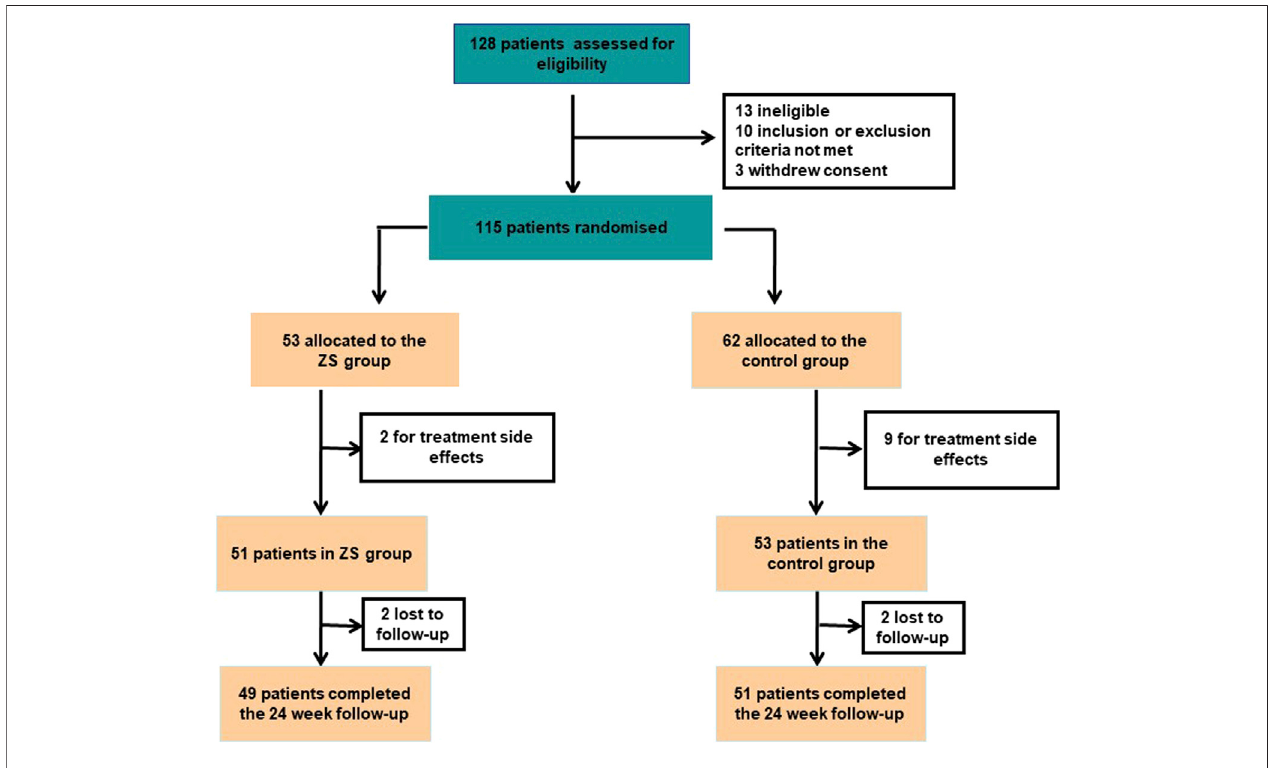
FIGURE 1 | Flow diagram of included studies.